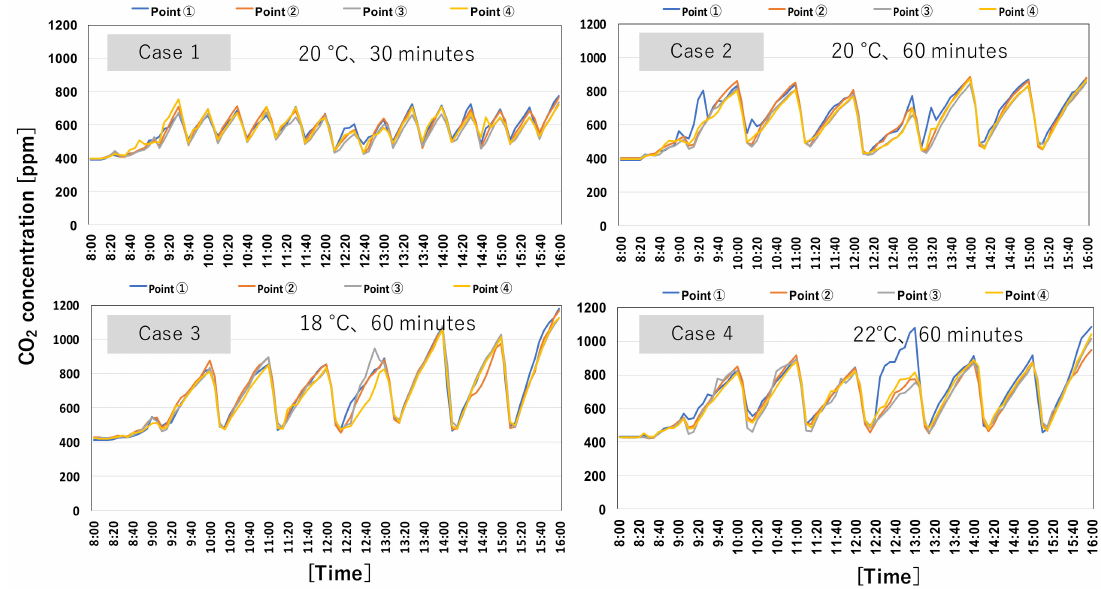
Figure 8. Changes of indoor CO 2 concentration in